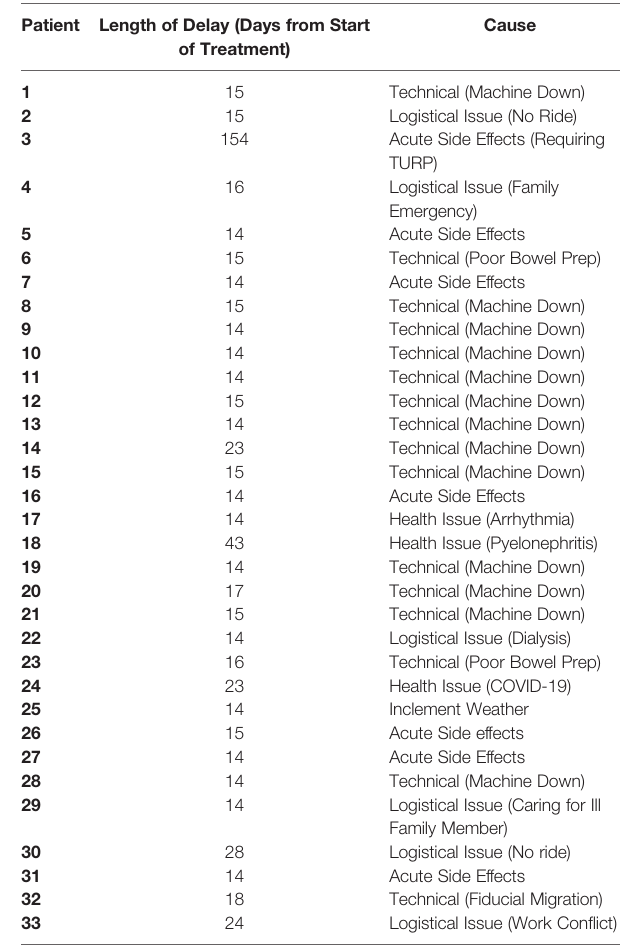
TABLE 2 | Length of Delay and Cause for Individual Patients. Patient Length of Delay (Days from Start of